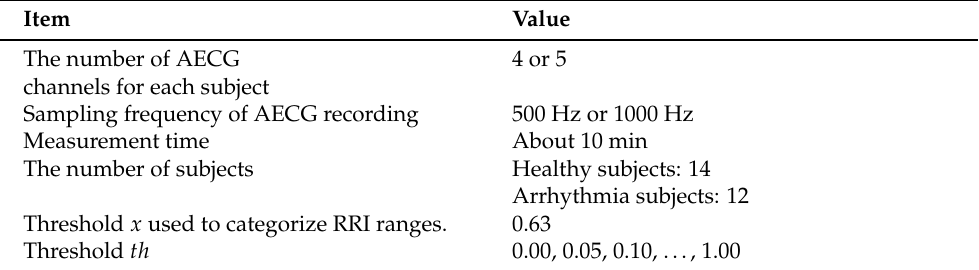
Table 1. Experimental